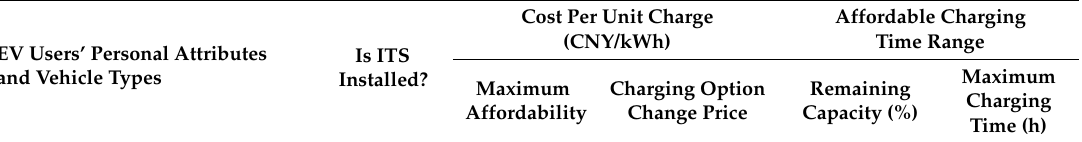
Table 1. Standard statistics summary table for the fast charging location selection of EV